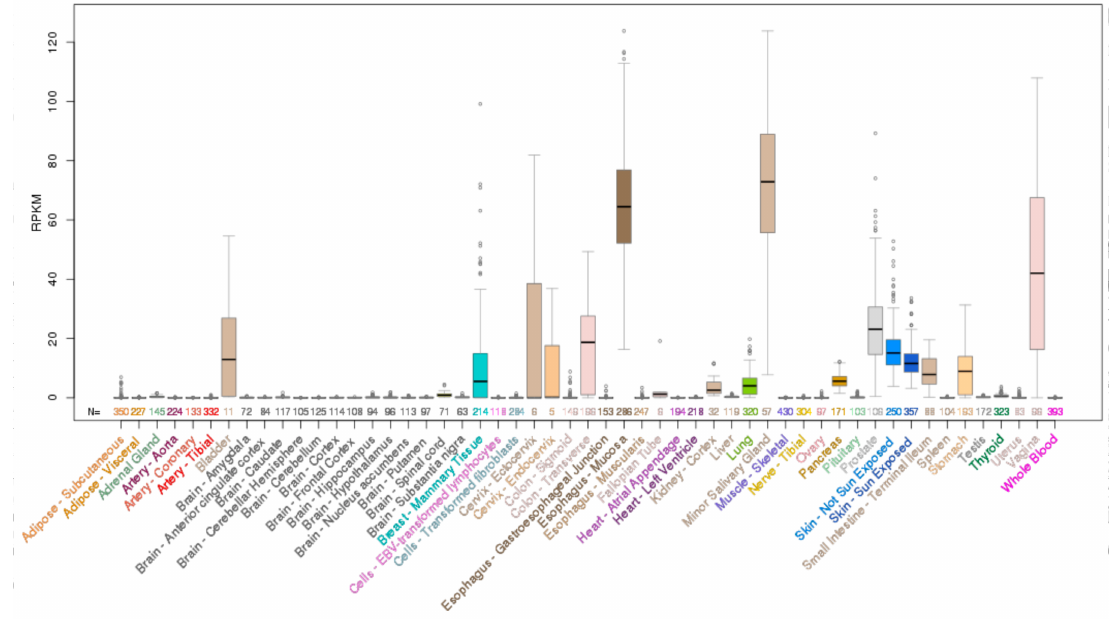
Figure 7. Expression of EHF mRNA across normal human tissues. Data obtained from UCSC genome